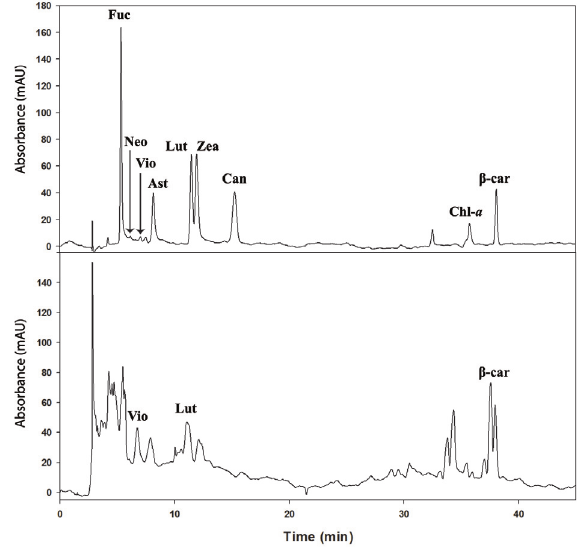
Figure 2: Chromatogram of HPLC-DAD (446 nm) assessment of pigments. Top: chromatogram of the standard containing fucoxanthin (Fuc), neoxanthin (Neo), violaxanthin (Vio), astaxanthin, (Ast), lutein (Lut), zeaxanthin (Zea), canthaxanthin (Can), chlorophyll a (Chl- a ) and β -carotene ( β -car); Bottom: chromatogram of the UM showing the detected